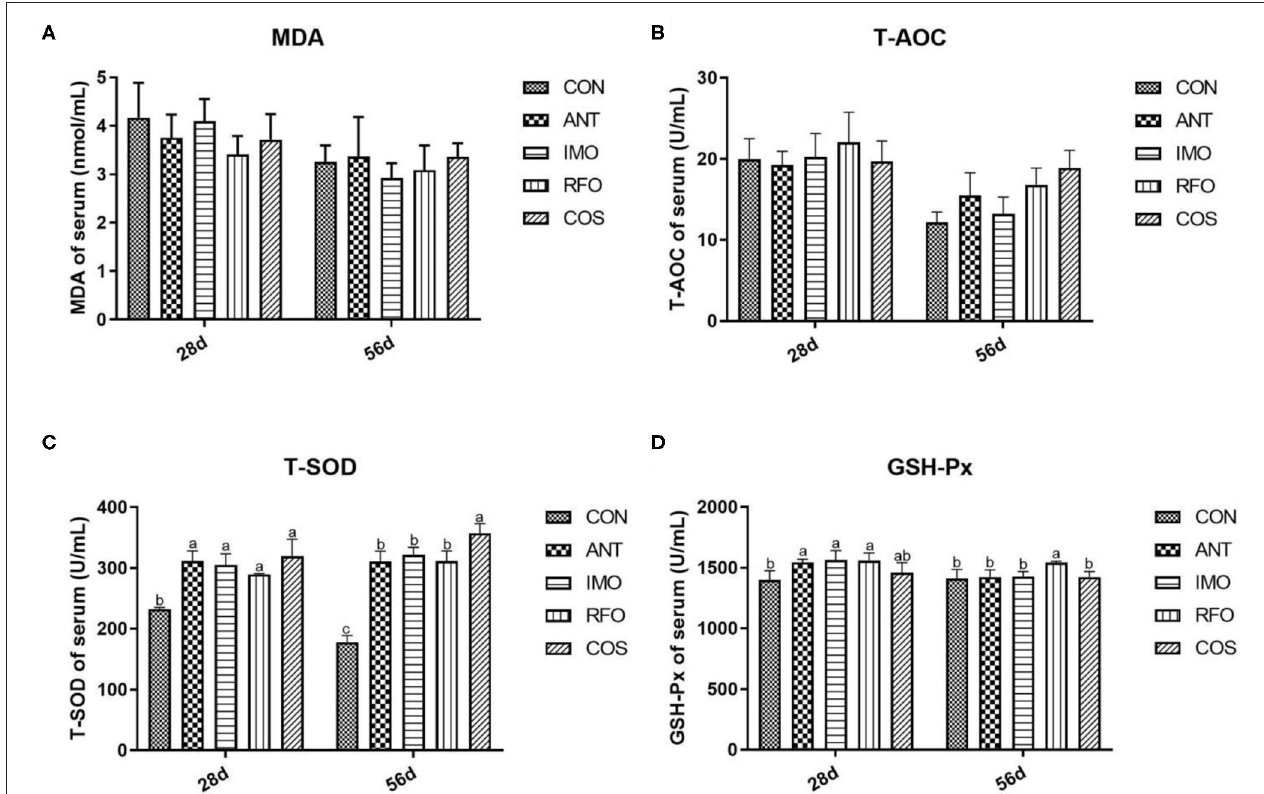
FIGURE 1 | Effects of different treatments on antioxidant indices in serum ( n = 6). (A) MDA, (B) T-AOC, (C) T-SOD, and (D) GSH-Px. Graph bars marked with different letters on top represent statistically significant results ( p < 0.05) based on ANOVA with Duncan’s range tests. CON, control group; ANT, ANT group; IMO, IMO group; RFO, RFO group; COS, COS group.